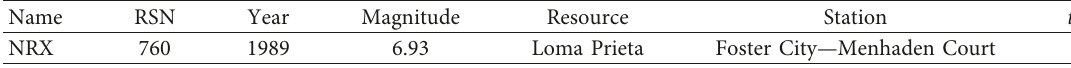
Figure 2: Normalized spectra of AWX and NRX. Table 1: Information of NRX.